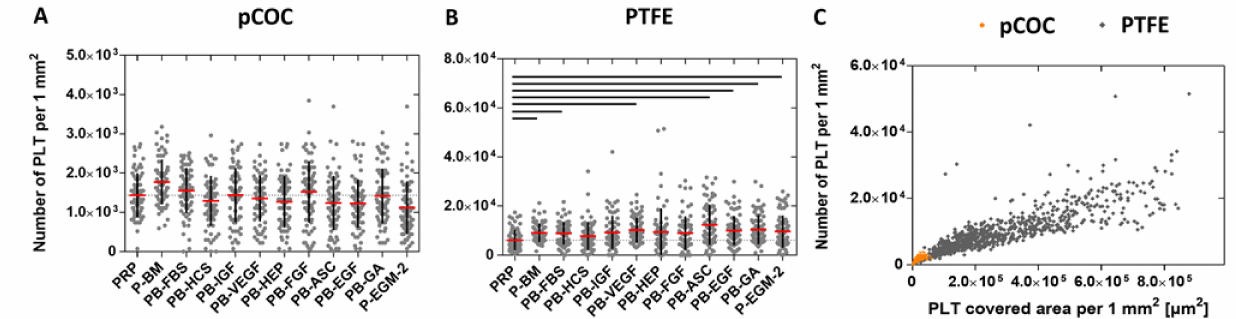
Figure 4. Polymer-dependent promotion of platelet (PLT) adherence. Platelet-rich plasma (PRP) was incubated under static conditions for 1 h at 37 ◦ C with basal medium (BM) or with BM containing one of nine different supplements or with BM containing all nine supplements (see Table 1 for nomenclature) in a ratio of 1:1 resulting in a concentration of 50,000 PLT µ L − 1 . PRP served as control. Images of phalloidin-stained PLT were quantitatively analyzed by ImageJ software. Shown are the number of adherent PLT on COC ( A ) and PTFE ( B ) as well as the relationship between PLT number and PLT covered area ( C ). Thin dashed line shows the value for PRP (control). Data represent the arithmetic mean (red) ± standard deviation (black), n = 72 per supplement. Black lines indicate significant differences with p ≤ 0.0475. A comparison of the two substrates regarding thrombogenicity shows that PTFE (grey rhombuses) is more thrombogenic than COC (orange circles; C). n = 864 for each